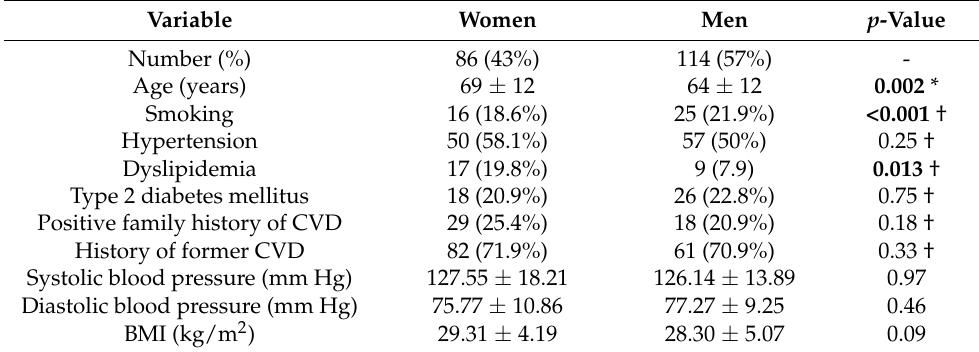
Table 1. Demographic and clinical characteristics of patients.